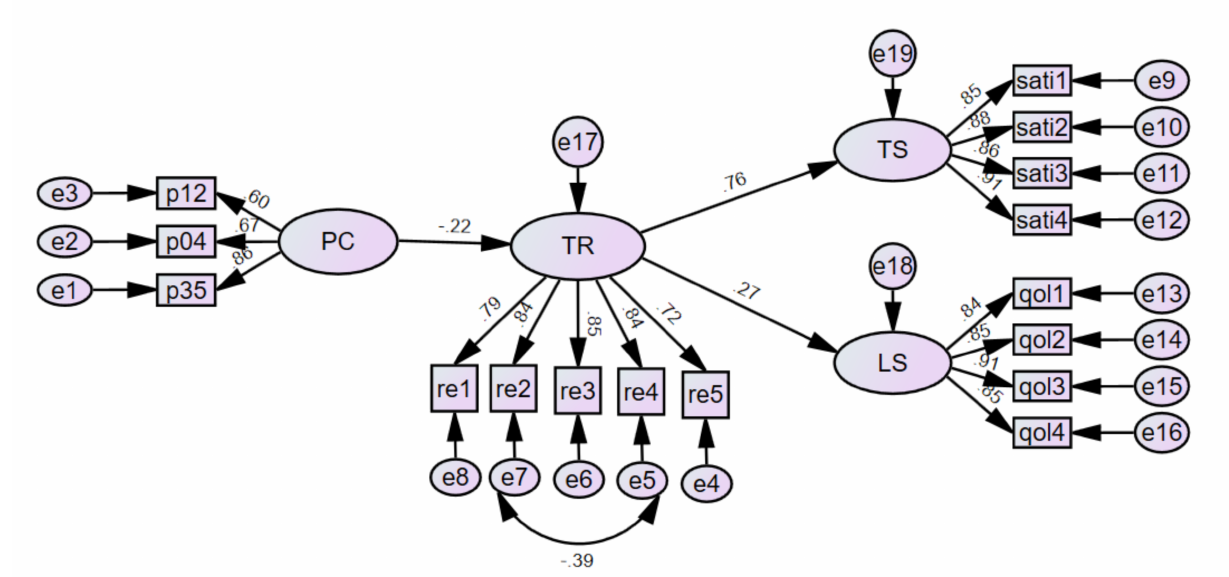
Figure 2. Standardized regression weights of the final research model. PC: perceived coercion, TR: therapeutic relationship, TS: therapeutic satisfaction, LS: life